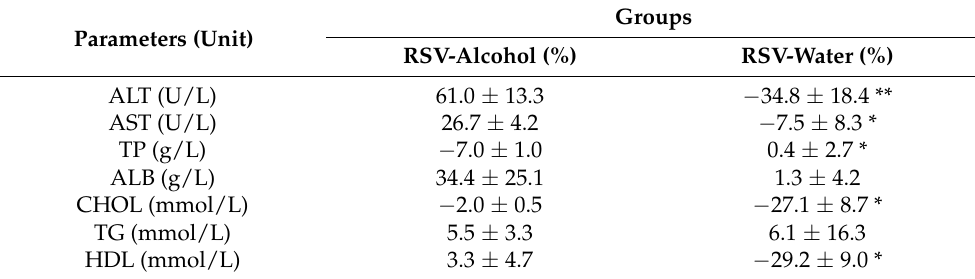
Table 2. Percentage change in serum biochemical indexes relative to ALD mice.